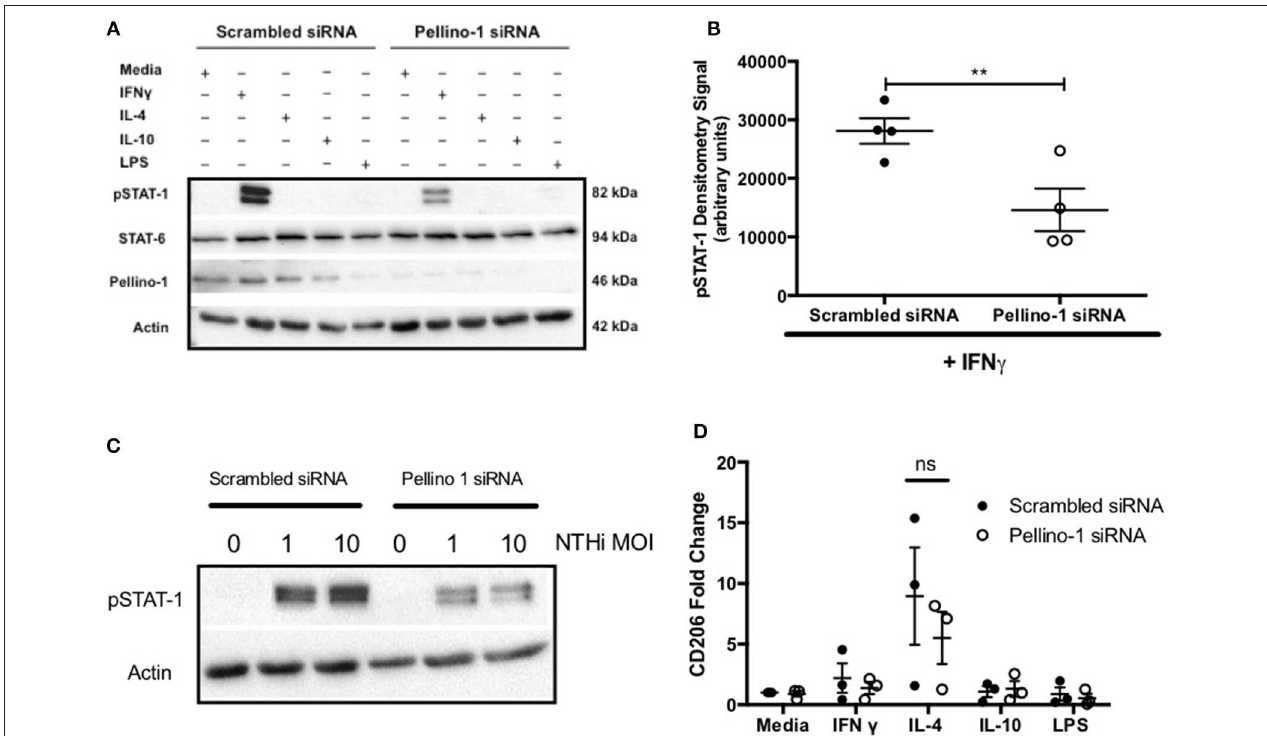
FIGURE 6 | Pellino-1 regulates macrophage STAT-1 signaling. MDMs were transfected with siRNA targeting Pellino-1 or scrambled siRNA (control). (A,B,D) 48h following transfection, cells were stimulated with IFN- γ [20ng/ml], IL-4 [20ng/ml], IL-10 [20ng/ml] or LPS [1ng/ml] for 24h. Whole cell lysates were analyzed by Western blot using antibodies specific to STAT-1, pSTAT-6, Pellino-1 or actin for 4 independent donors (A) . pSTAT-1 bands for IFN- γ -treated cells were analyzed by densitometry (B) . In separate experiments cells were challenged with NTHi (MOI 1 and 10) for 24h and lysates probed for Pellino-1 and actin (C) . RNA was purified from cell lysates and transcribed to cDNA. CD206 gene product was measured by qPCR (D) . Fold changes are shown relative to media treated MDMs transfected with scrambled siRNA (first open bar). Data are presented as mean ± SEM of n = 4 independent experiments. Significant differences are indicated by ** P <